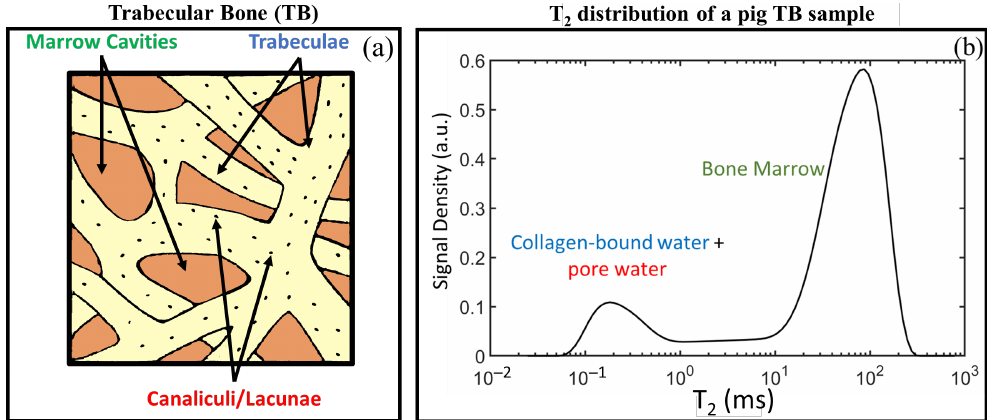
Figure 2. ( a ) Schematic representation of trabecular bone indicating its constituents; ( b ) T 2 distribu- tion of a trabecular bone sample cored from a pig shoulder (plot from data used in reference